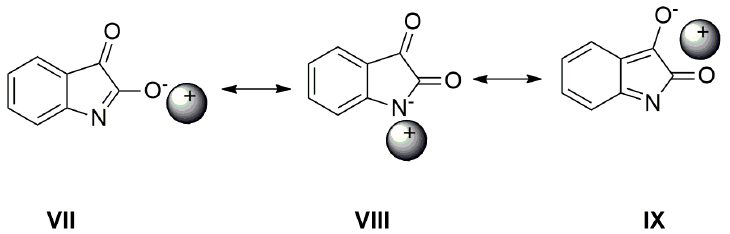
Figure 5. Change of FTIR spectra of A (1 × 10 − 2 mol·dm − 3 ) in CHCl 3 depending on the TBAF concentration.